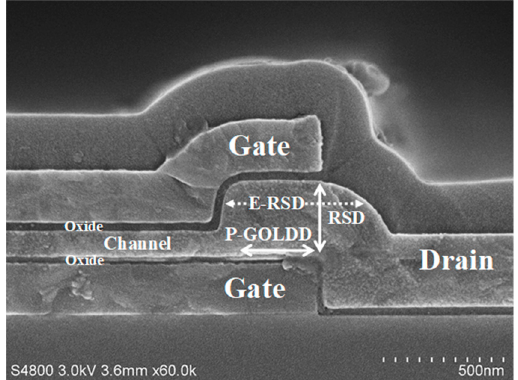
Figure 3. SEM image of double-gate two-step source/drain Poly-Si TFT.